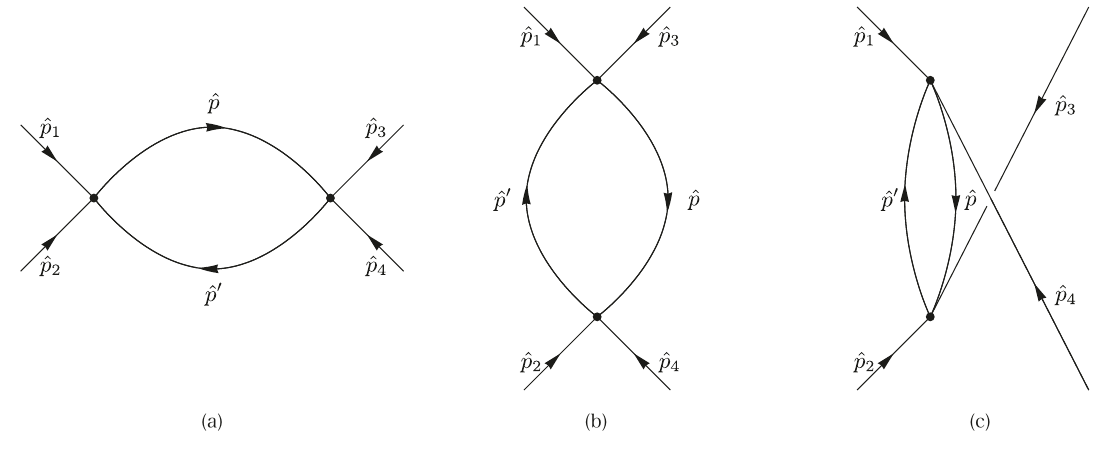
Figure 7 . One-loop corrections to the four point